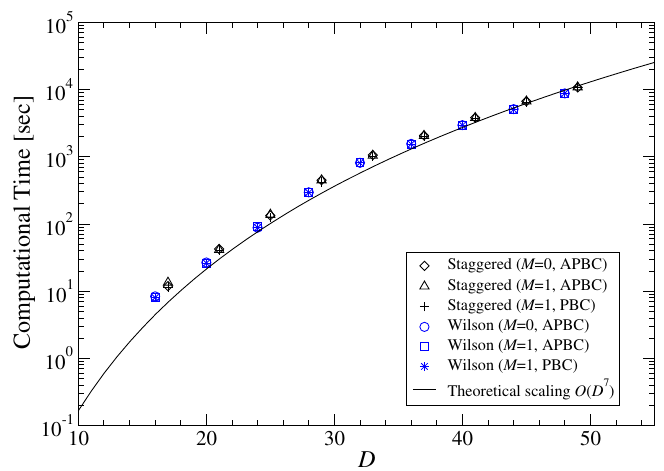
Figure 7 . Computational time of free energy density on 1024 × 1024 lattice as a function of D . For the massive cases, we evaluated the path integrals assuming the periodic boundary condition (PBC) and anti-periodic one (APBC) for 2 -direction. Solid curve shows the theoretical scaling of computational time, which holds whether the fermions are massless or massive regardless of the type of lattice fermion.